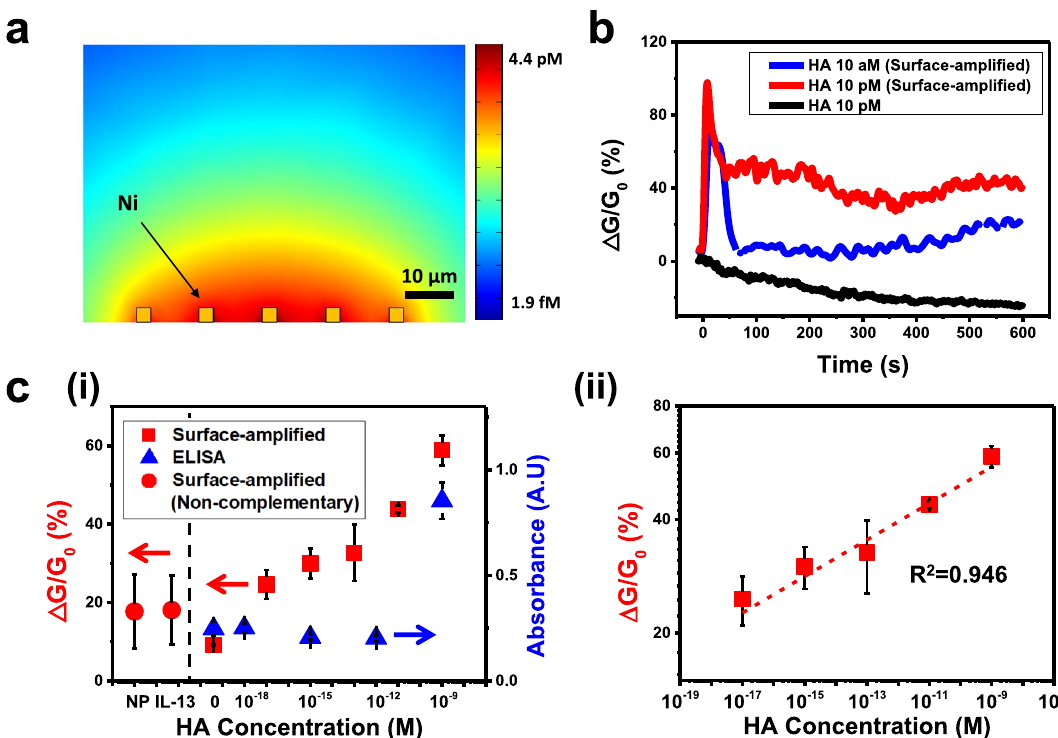
Figure 3. Repeated sensing measurements to detect hemagglutinin (HA) proteins of influenza A (H1N1) virus via surface-amplified sandwich immunoassay. ( a ) Simulation result showing AP concentrations after AP diffusion in the surface-amplified sandwich immunoassay. ( b ) Real-time sensor responses to various concentrations of HA with and without the surface amplification of signals. ( c ) Dose-dependence response curves of the surface-amplified immunoassay (n = 3) and conventional ELISA measurements (n = 5) using the same 1st and 2nd antibodies (i) . Each data point and error bar represents the average value and standard deviation of the experiments. Log–log scale plot showing linearity of our sensor response against HA concentrations ( ii the signals with trapped sandwich structures were stabilized around 600 s after the APP injection, the saturated sensor signals were utilized as a sensor signal. Note that the sensor signal for the 10 aM HA solution (blue line) was much smaller than that for the 10 pM HA solution (red line), indicating that our method can be utilized to quantitatively measure the concentration of target solutions. Also, it should be mentioned that the sensor signal without trapping sandwich structures from 10 pM HA solution (black line) was even smaller than that with trapped sandwich structures from 10 aM solution (blue line), indicating the signal enhancement effect by more than 10 6 times. Presumably, the enzyme in the sandwich structures trapped near the electrodes generated AP with a high concentration near our sensor surface, enhancing the sensor signals. These results show that our strategy of trapping the enzyme-functionalized sandwich structures on the sensor surface can significantly improve the sensor sensitivity. Figure 3c (i) shows the dose-dependent responses of the HA sensing measurements with our surface-amplified immunoassay strategy (red squares, n = 3) as well as conventional enzyme-linked immunosorbent assay (ELISA) methods (blue triangles, n = 5). Here, HA solutions with their concentrations ranging from 10 aM to 1 nM were used for the surface-amplified immunoassay. Also, non-specific responses of our sensor were tested by measuring the sensor responses to non-targeted nucleoproteins (NP) of influenza A (H1N1) virus and interleukin 13 (IL- 13) with a 10 pM concentration (red circles). It should be noted that all 24 sensing measurements of our surface amplified immunoassay were performed on a single sensor chip (Fig. 3c(i)). Conventional ELISA measurements were performed using the same antibody and HA target protein as our sensors. The detailed experimental procedures are presented in supplementary information. Our sensor began to show responses to 10 aM HA solution, and the responses increased with increasing HA concentrations. However, the non-specific responses to NP and IL-13 were negligibly small compared to those to HA sensing results. These results clearly show the high sensitivity and selectivity of our surface amplified immunoassay. On the other hand, the conventional ELISA method using the same antibody shows sensing signals from the 1 nM HA solution. Although the same antibodies with their binding constants of a few nanomolar range were used in both sensing measurements, our surface amplified immunoassay showed a detection limit which is lower, by more than ~ 10 7 times, than that of the conventional ELISA. Presumably, the signal amplification by enzyme near the sensor surface should have enabled such signal enhancements as discussed in Fig. 3b. Importantly, in this sensing experiment, a single sensor was utilized to perform more than 20 times of repeated measurements, while still providing consistent results at